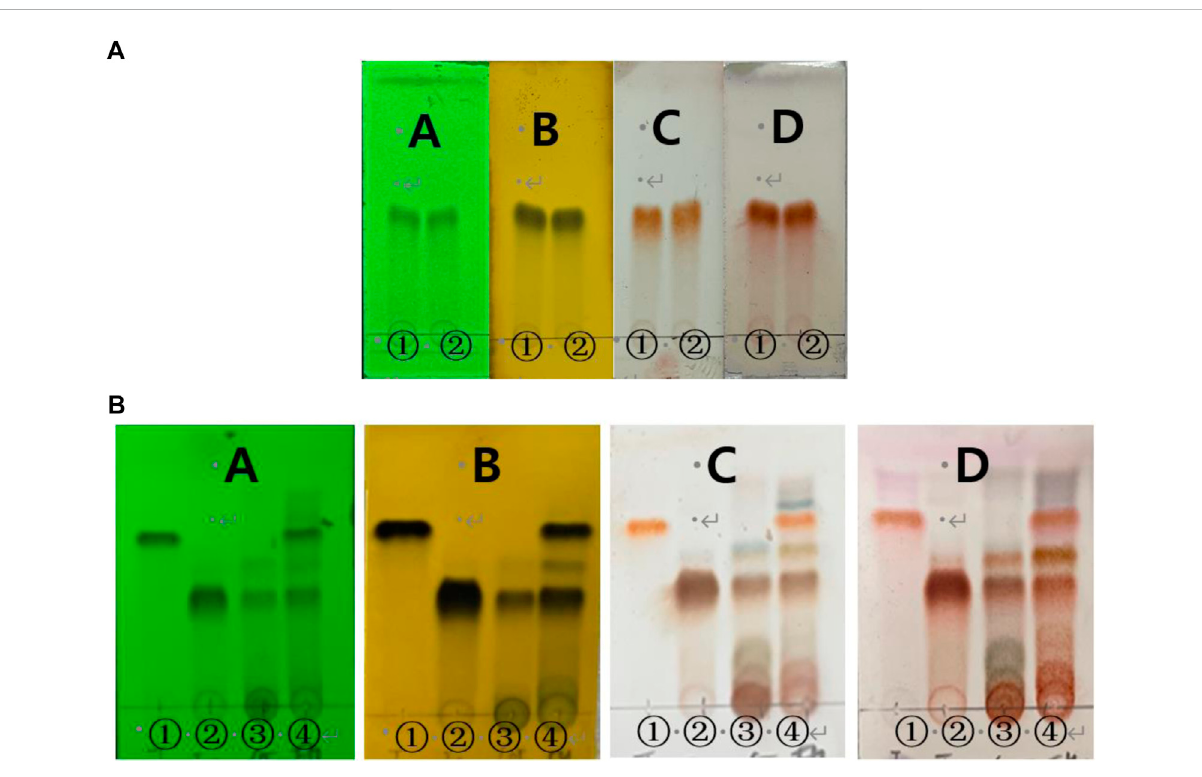
TLC monitoring of (A) taxifolin and compound 1. A = UV radiation (254 nm), B = FeCl 3 , C = 10% H 2 SO 4 D = ρ -anisaldehyde H 2 SO 4 . 1 = taxifolin, 2 = compound 1. Chloroform:Methanol = 5:1 and (B) compound 1, taxifolin glycoside, RM60E, enzymatic hydrolysis of RM. A = UV radiation (254 nm), B=FeCl 3 ,C =10%H 2 SO 4 D= ρ -anisaldehydeH 2 SO 4 .1= compound 1,2=taxifolinglycoside,3=RM60E,4=enzymatichydrolysis ofRM. Chloroform:Methanol:Water =